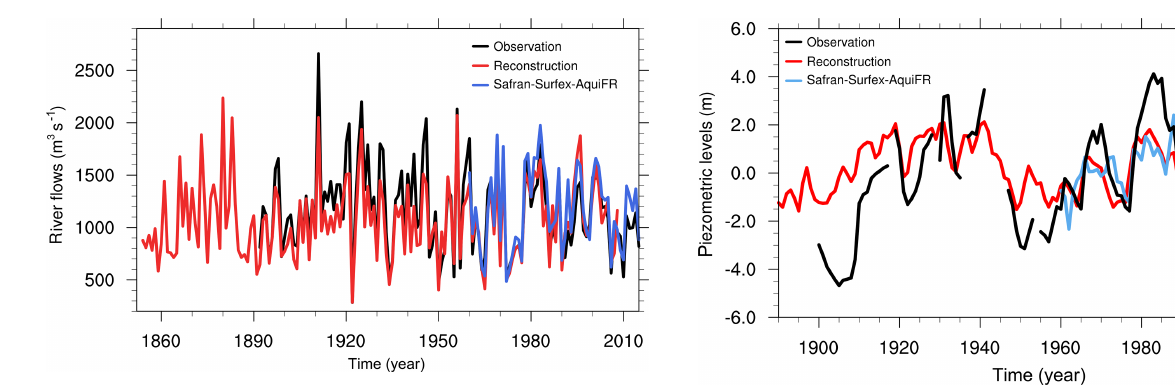
Figure 6. Annual anomalies of the piezometric levels of the Beauce groundwater table at Toury. The reference period is 1960–2005. Black: observations. Red: Seine reconstruction. Blue: reference simulation